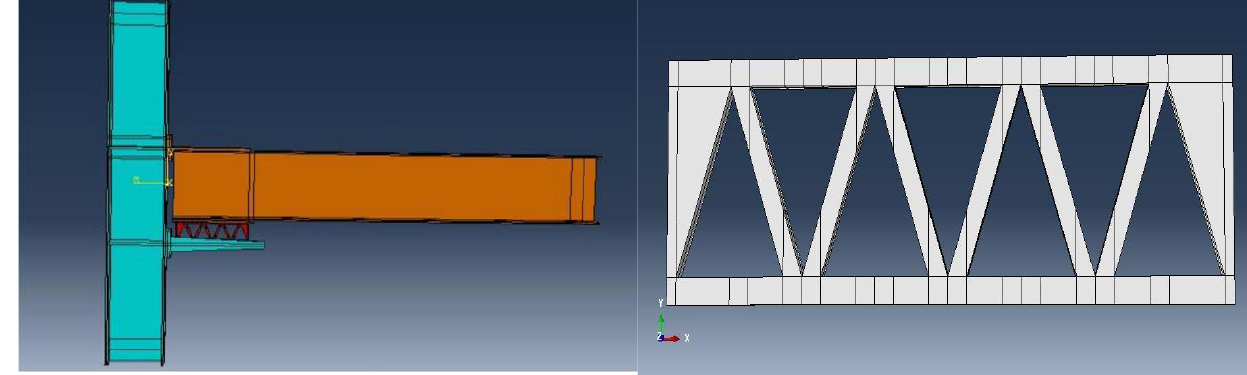
Figure 3. The triangular shape of slit damper whitebeam-column